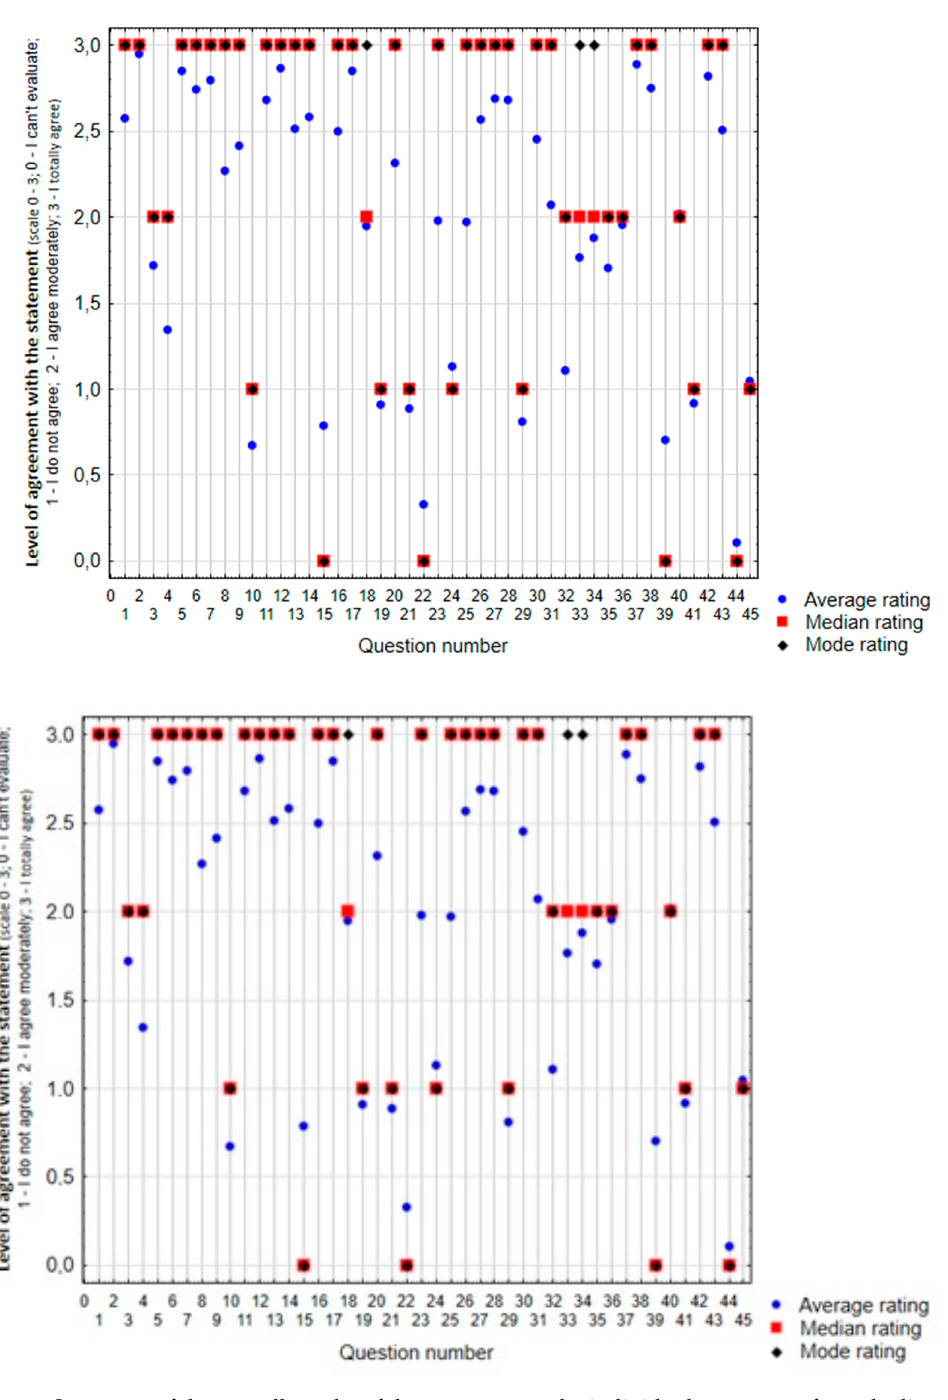
Figure 1. Summary of the overall results of the responses to the individual statements from the list of statements (average rating, median, and mode of evaluation on a scale of 0–3).